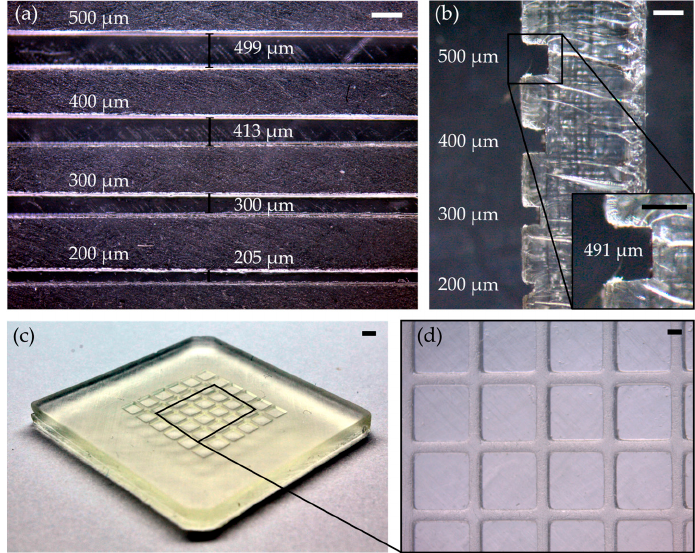
Figure 6. PFPE-printed open channels with a height and width of 500 µm, 400 µm, 300 µm, 200 µm and an exemplary printed PFPE chessboard structure: ( a ) The top view of the open channels shows a high conformity of the channel width (scale bar: 500 µm); ( b ) The lateral view shows the accordance of the channel heights with the set values. The inset shows the cross section of the 500 µm channel with a channel height of approximately 491 µm (scale bars: 500 µm); ( c ) Exemplary printed PFPE methacrylate chessboard structure (scale bar: 2 mm); and, ( d ) Microscope image of the chessboard from ( c ) (scale bar: 500 µm).